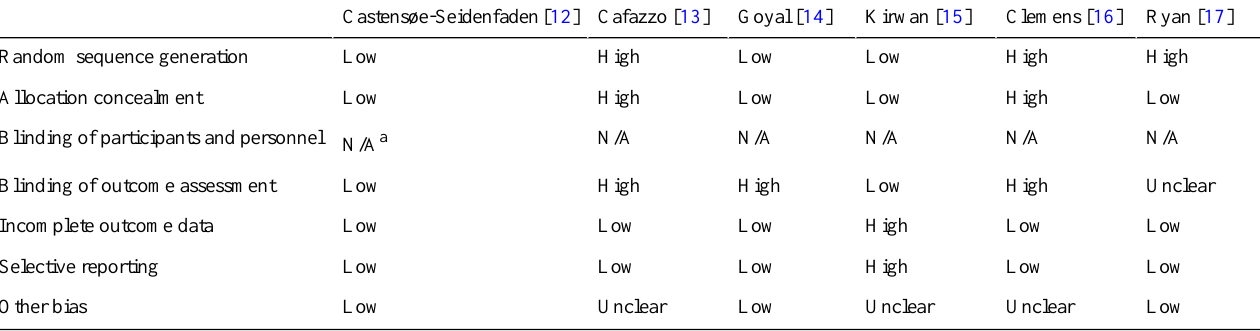
Table 2. Cochrane Collaboration’s tool risk-of-bias assessment for the clinical outcomes (hemoglobin A 1c and self-monitoring blood glucose changes) of the included study